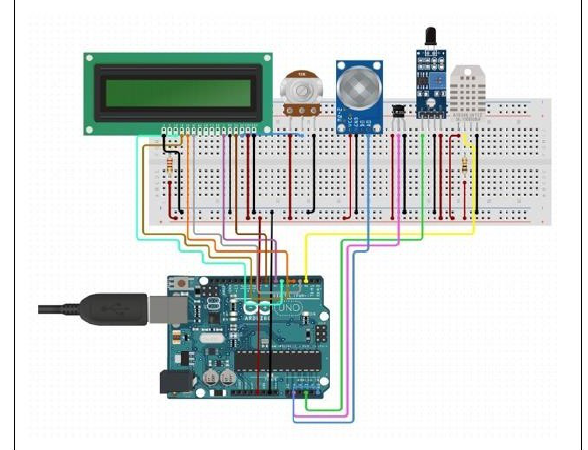
Fig. 6 : Prototype Of Monitoring System in Control